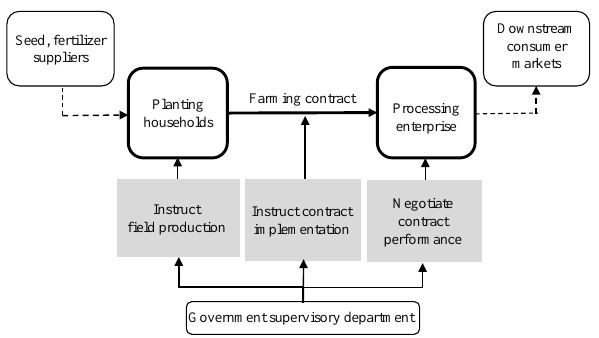
Figure 1. Basic structure of the sugar industry of contract farming in